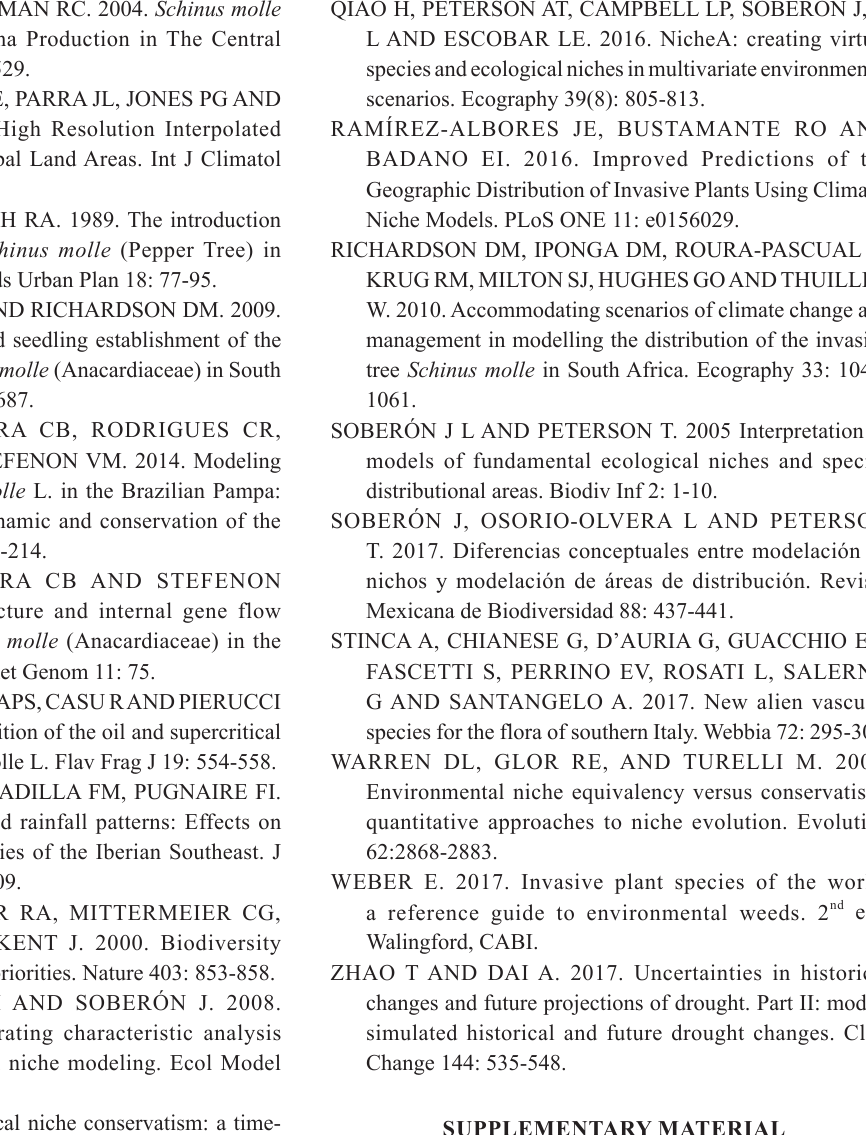
Table SI - Percent of contribution of the nineteen current climatic variables determining the occurrence areas of Schinus molle in the globe in the first MaxEnt